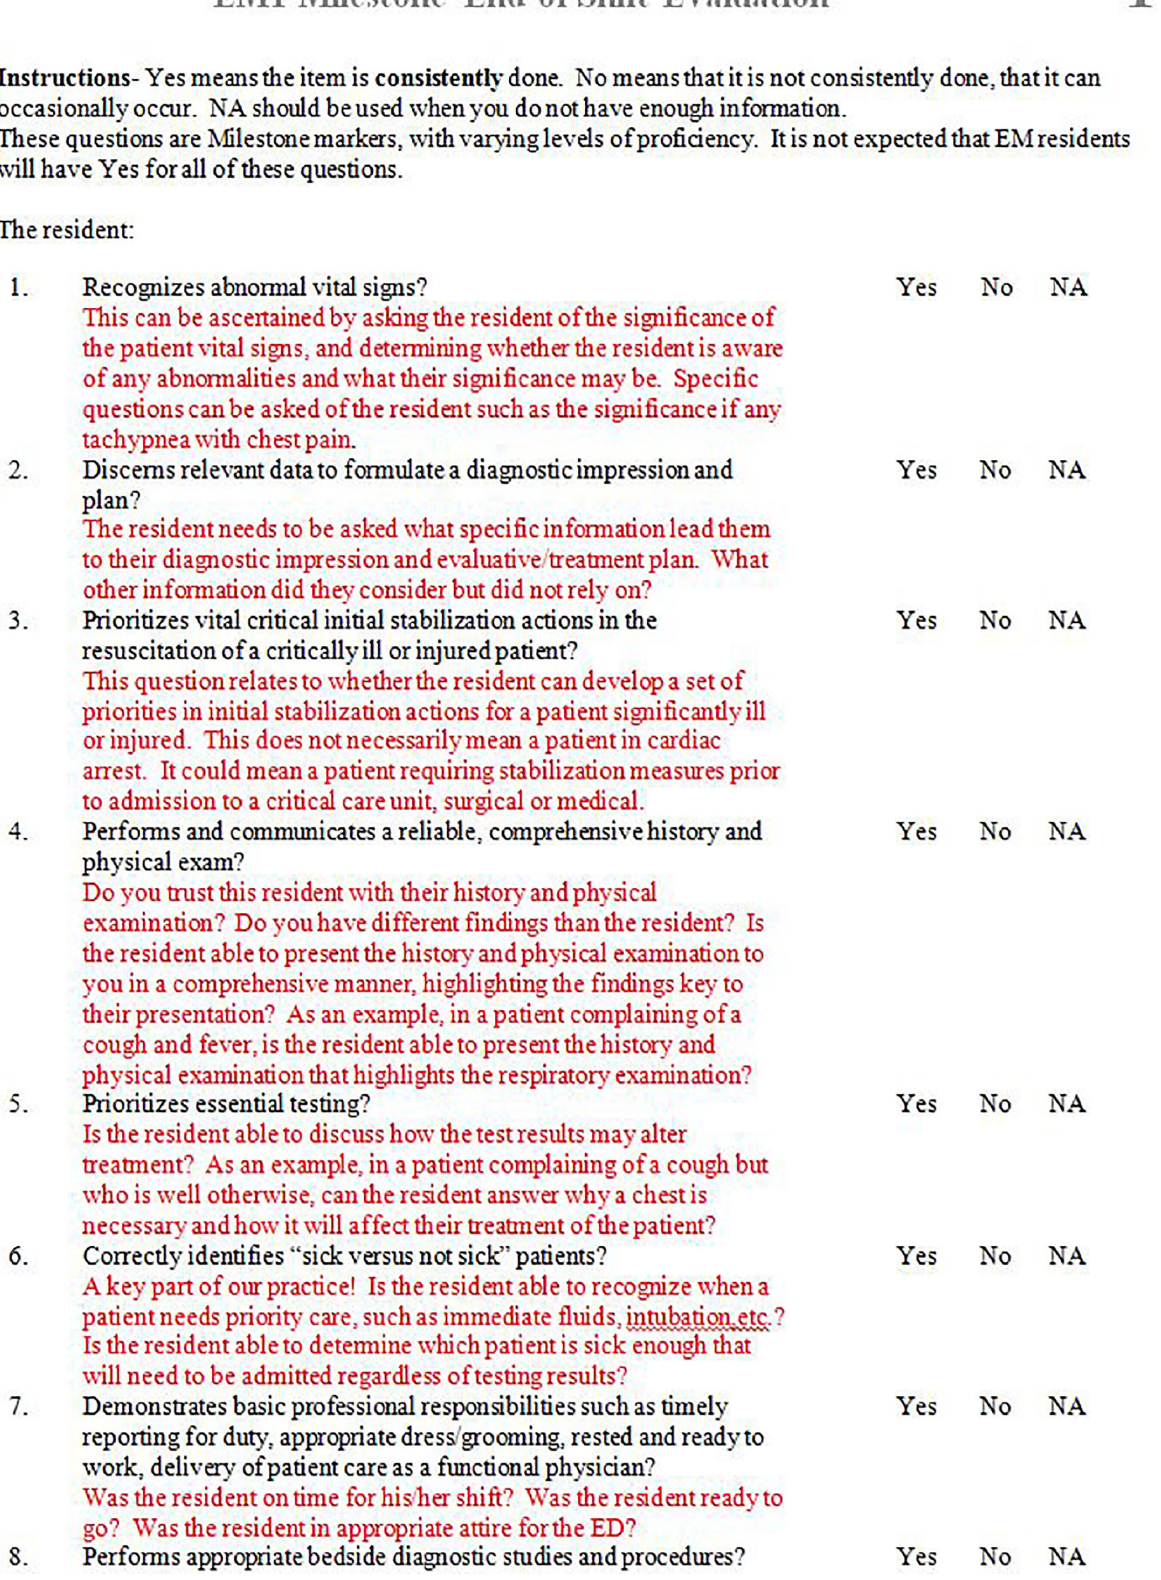
Figure 2. One scoring anchor for an end-of-shift evaluation